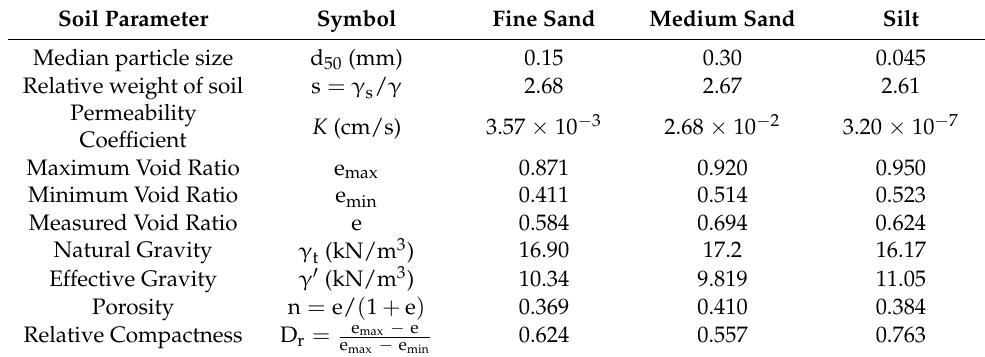
Table 1. Basic parameters of the fine sandy soil.